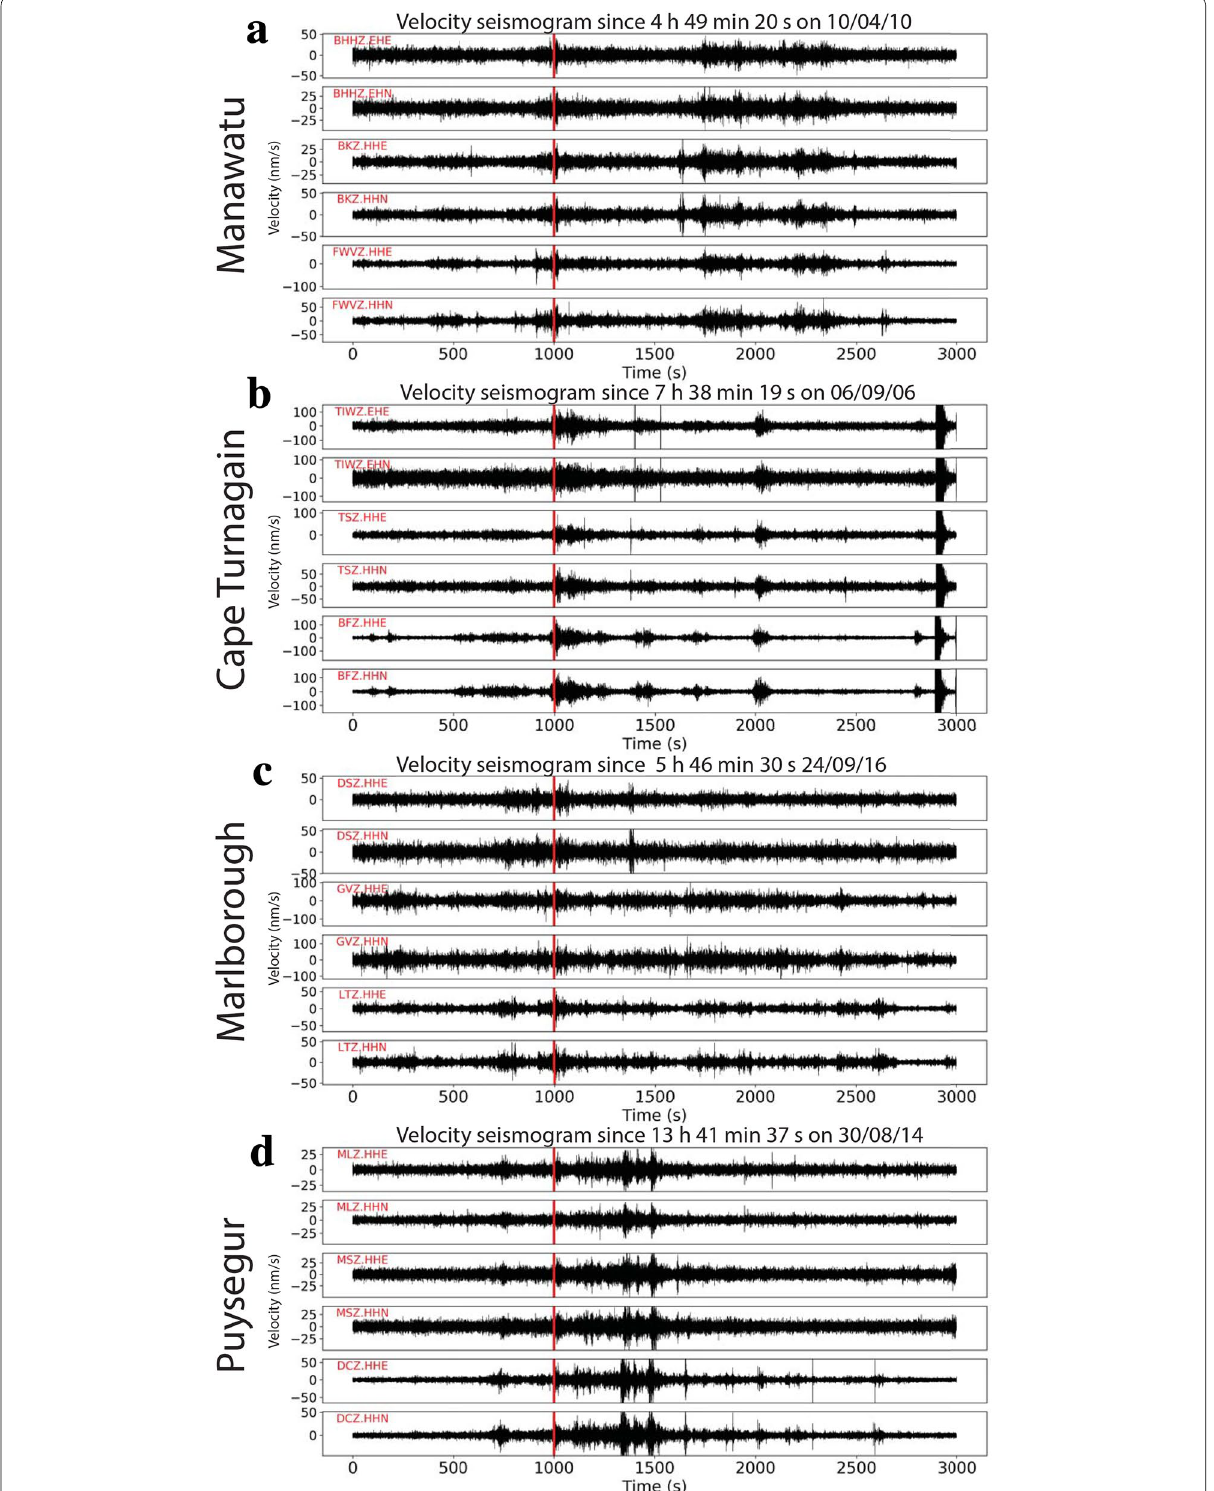
Fig. 3 Example of tremor velocity seismograms. Each seismogram is band-pass-filtered at 2–8 Hz. The horizontal red line indicates the time the event was detected via the cross-correlation